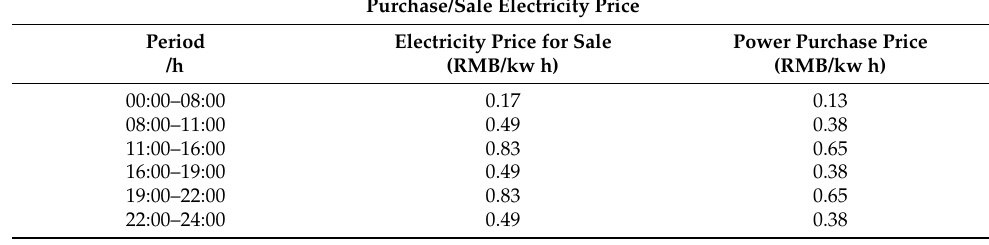
Figure 5. IEEE 33-bus distribution network. Figure 6. Typical PV output and load demand curve. Table 1. Time of use power price.